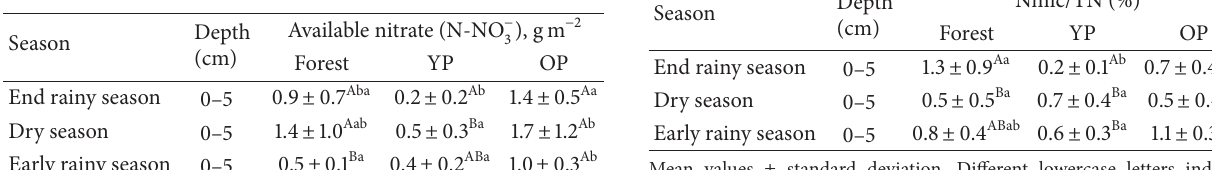
Table 3: Seasonal changes in the available soil nitrate in the forest and pastures.